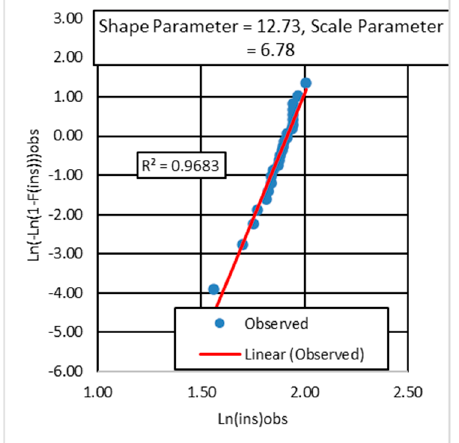
Figure 9. Weibull descriptors of weather stability.